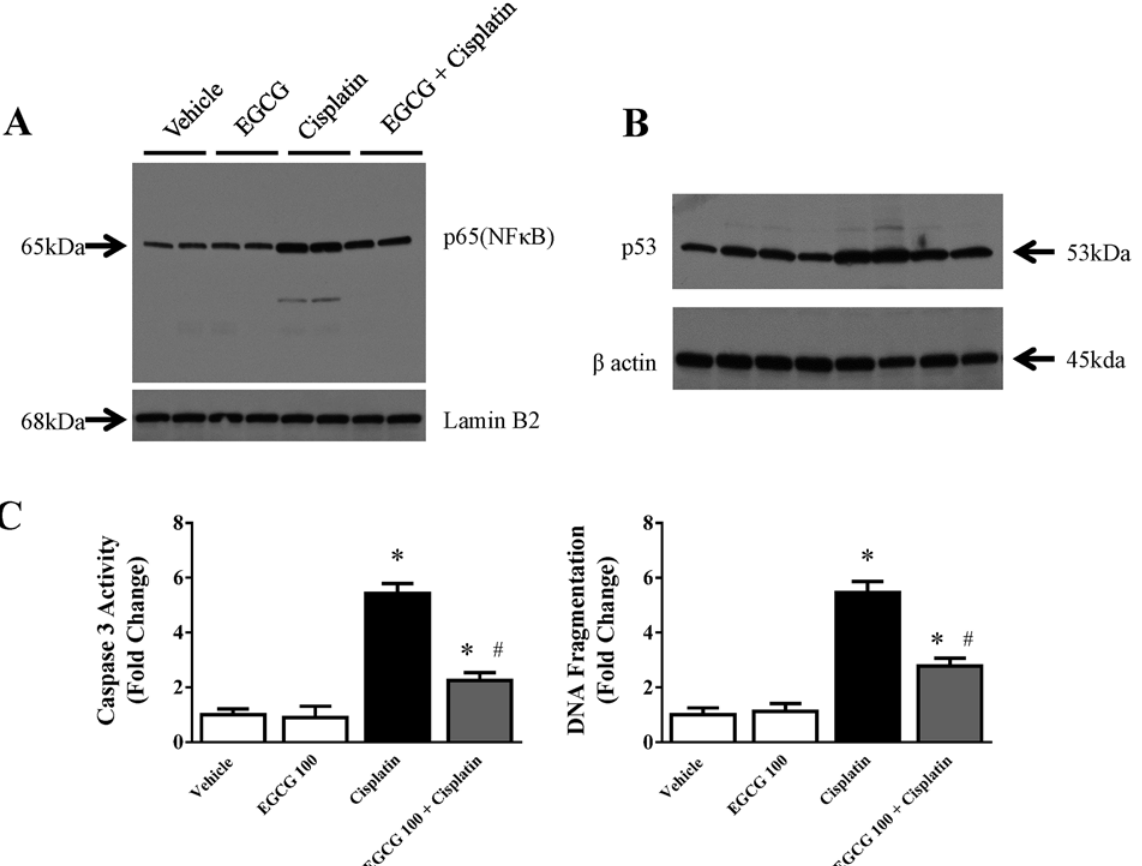
Fig 7. Effect of EGCG on cisplatin-induced nuclear translocation of NF κ B, induction of p53 and apoptosis. Panel A. Immuno-blot analyses of nuclear fraction from kidney demonstrated increase in p65 in cisplatin treated mice. The level is reduced in EGCG and cisplatin treated group. Panel B. Immuno-blot analyses of total lysate from kidney demonstrated increase in p53 in cisplatin treated mice. Panel C. Quantitative measurement of Caspase 3 activity and DNA fragmentation. Results are mean ± S.E.M. n = 4/group. * p < 0.05 versus vehicle; and # p < 0.05 versus cisplatin